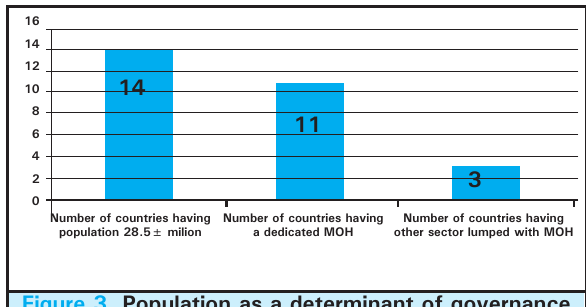
Figure 3. Population as a determinant of governance